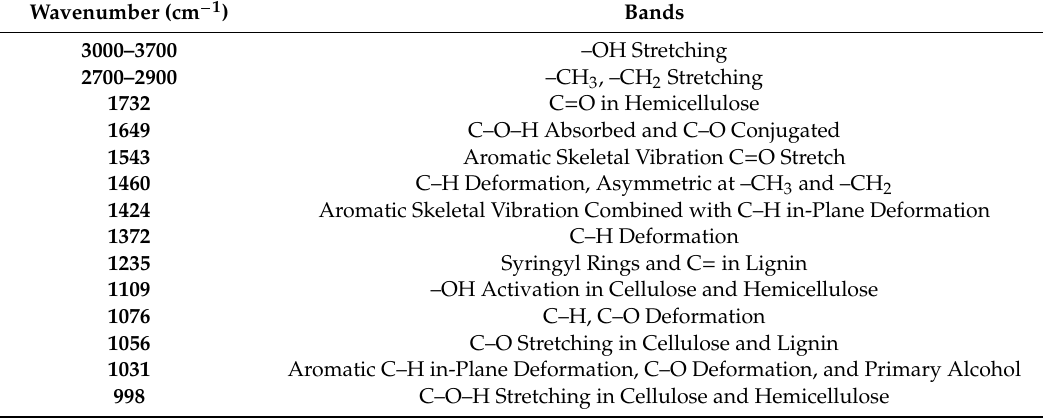
Table 5. Table of the present bonds and corresponding wavenumbers in the CP.